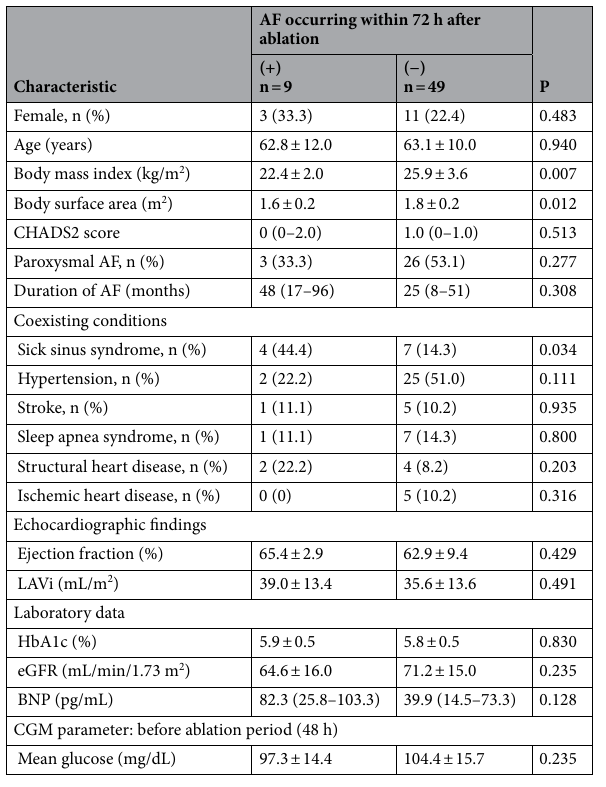
Table 3. Baseline clinical characteristics in patients with and without AF recurrence within 72 h after ablation. AF atrial fibrillation, LAVi left atrial volume index, eGFR estimated glomerular filtration rate, BNP brain natriuretic peptide, CGM continuous glucose monitoring.